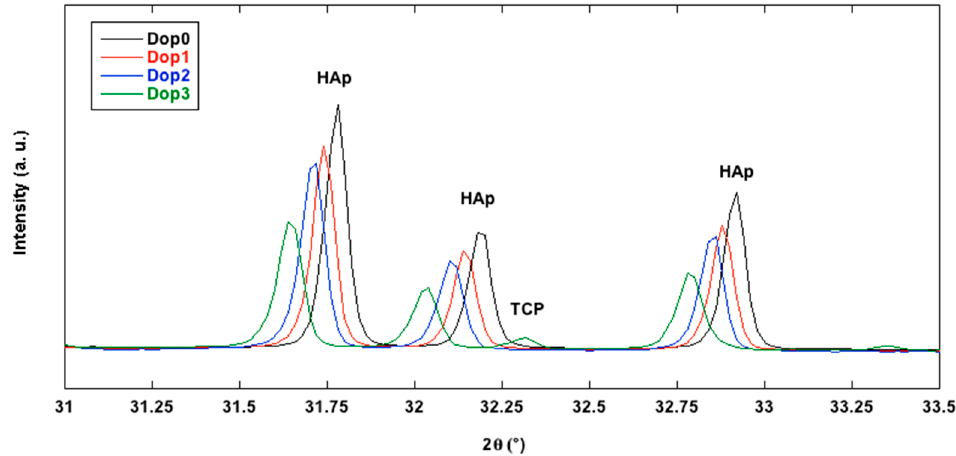
Figure 4. Variation in peak position as a function of Sr fraction for (Ca 1-x Sr x ) 10 (PO 4 ) 6 (OH) 2 hydroxy- apatite samples.